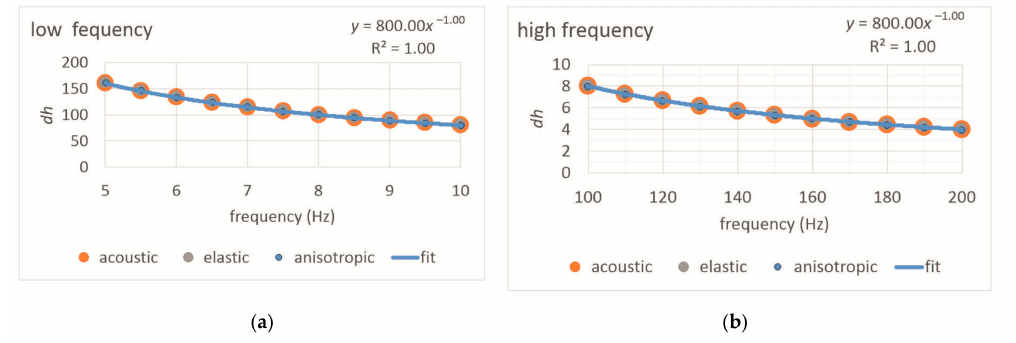
Figure 9. The relationships between the distance to the nearest calculation nodes dh (the largest allowable spatial modeling step) and source frequency for: low ( a ) and high ( b ) frequencies of the source wavelet.